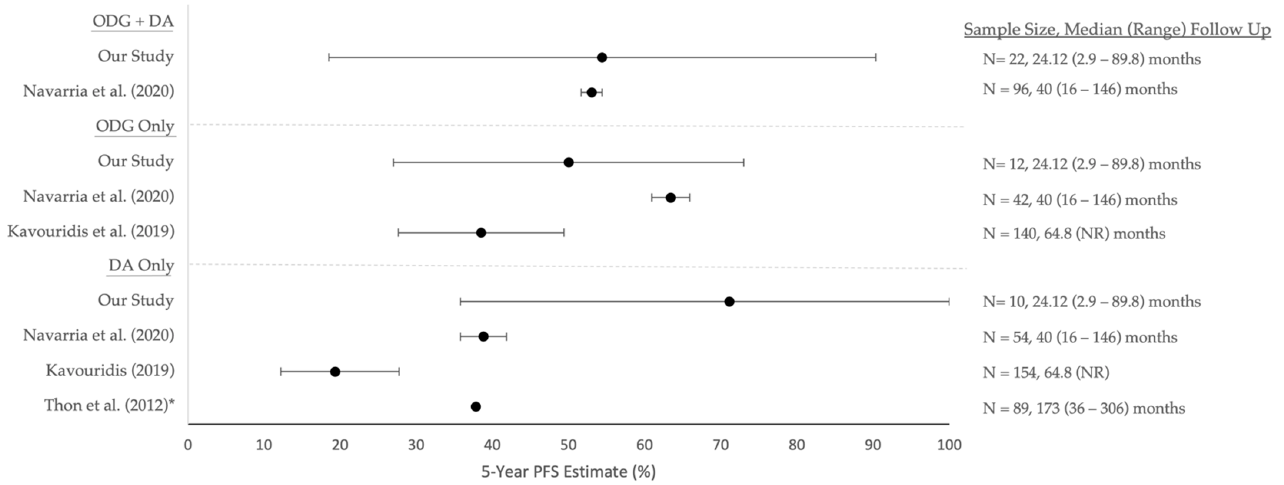
Figure 3. Five-year PFS estimates (95% confidence intervals) of prior surgical resection studies. Corresponding median (range) follow-up durations and sample sizes can be found on the right side for each study. * Indicates that a confidence interval was not provided or able to be calculated for that study. Abbreviations: PFS = progression-free survival, ODG = oligodendroglioma, DA = diffuse astrocytoma, NR = not reported.